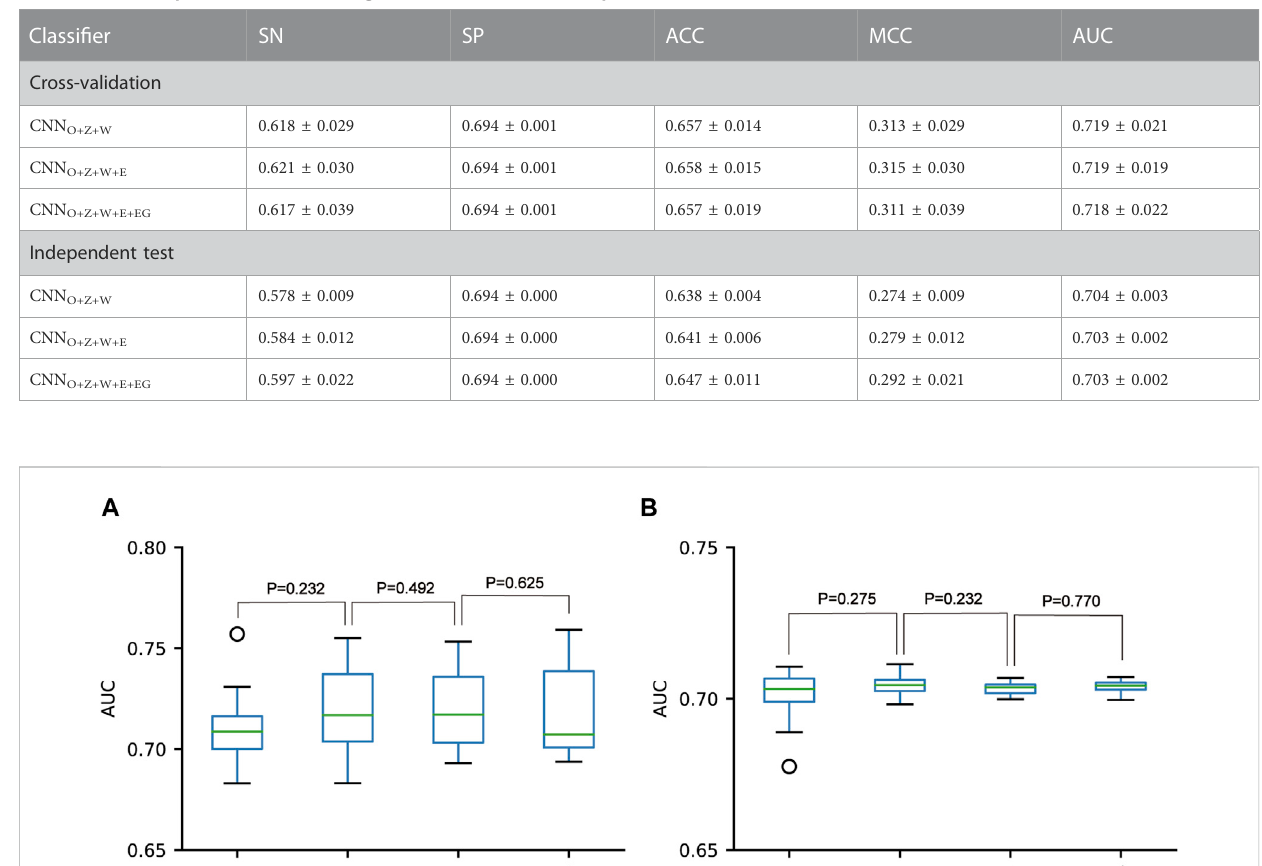
TABLE 2 Prediction performances of stacking ensemble classi fi ers for the pSADPr-SADPr dataset.